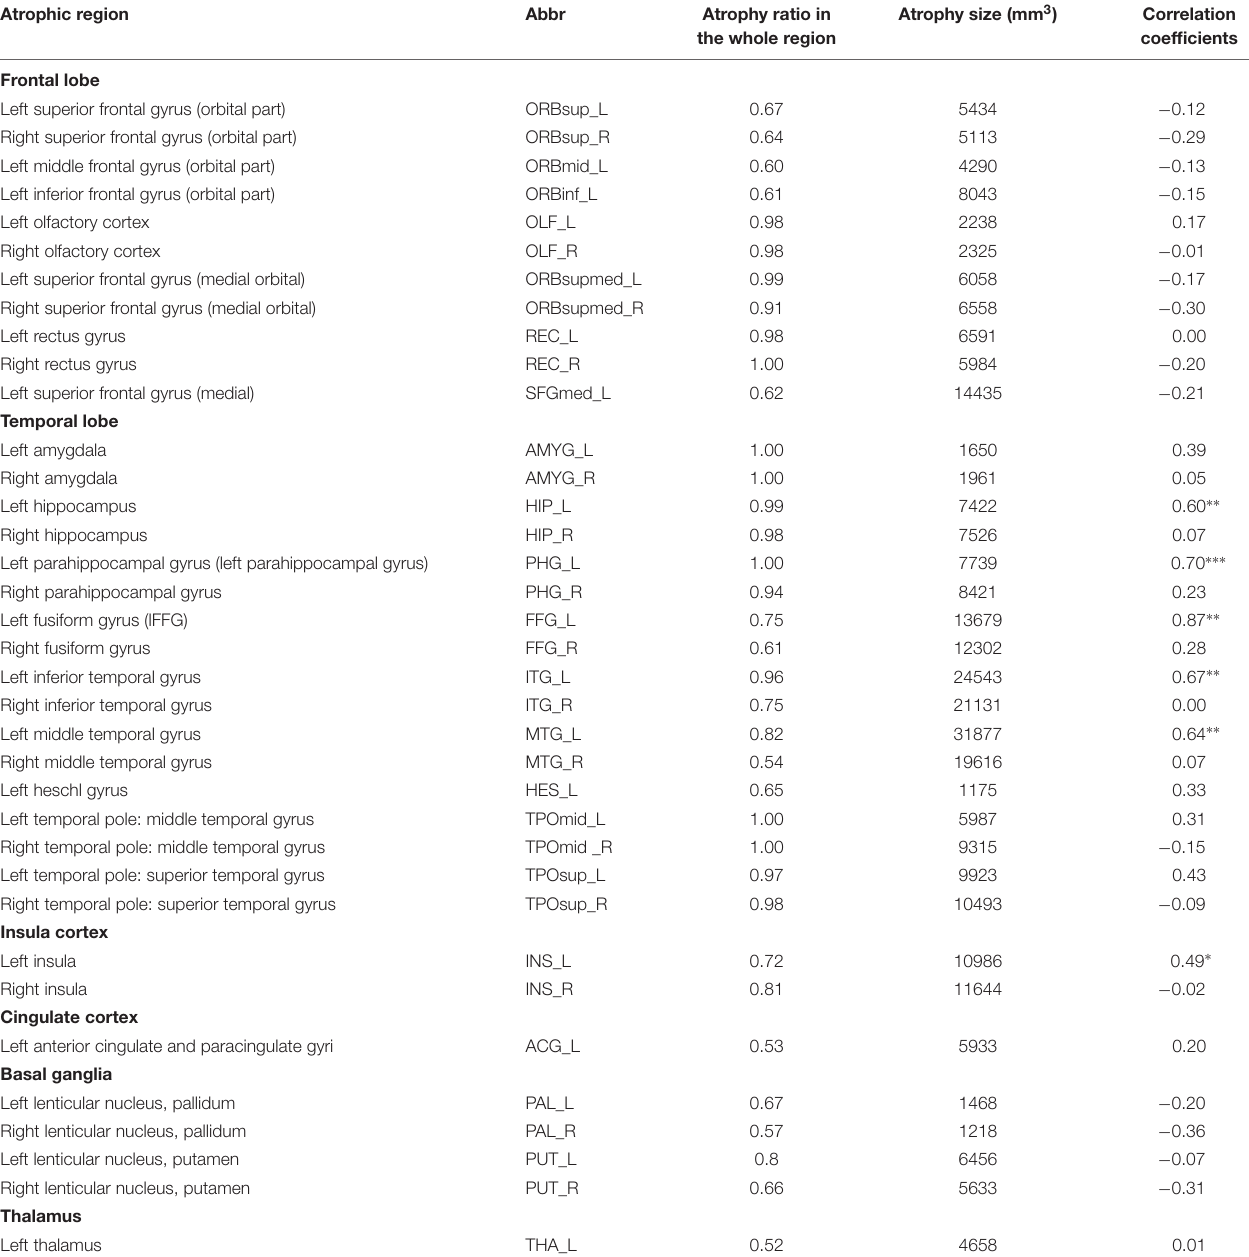
TABLE 2 | The characteristics of the 36 atrophic regions in SD patients and the correlation coefficients between the GMVs of each atrophic region and the semantic PCA scores. Atrophic region Abbr Atrophy ratio in